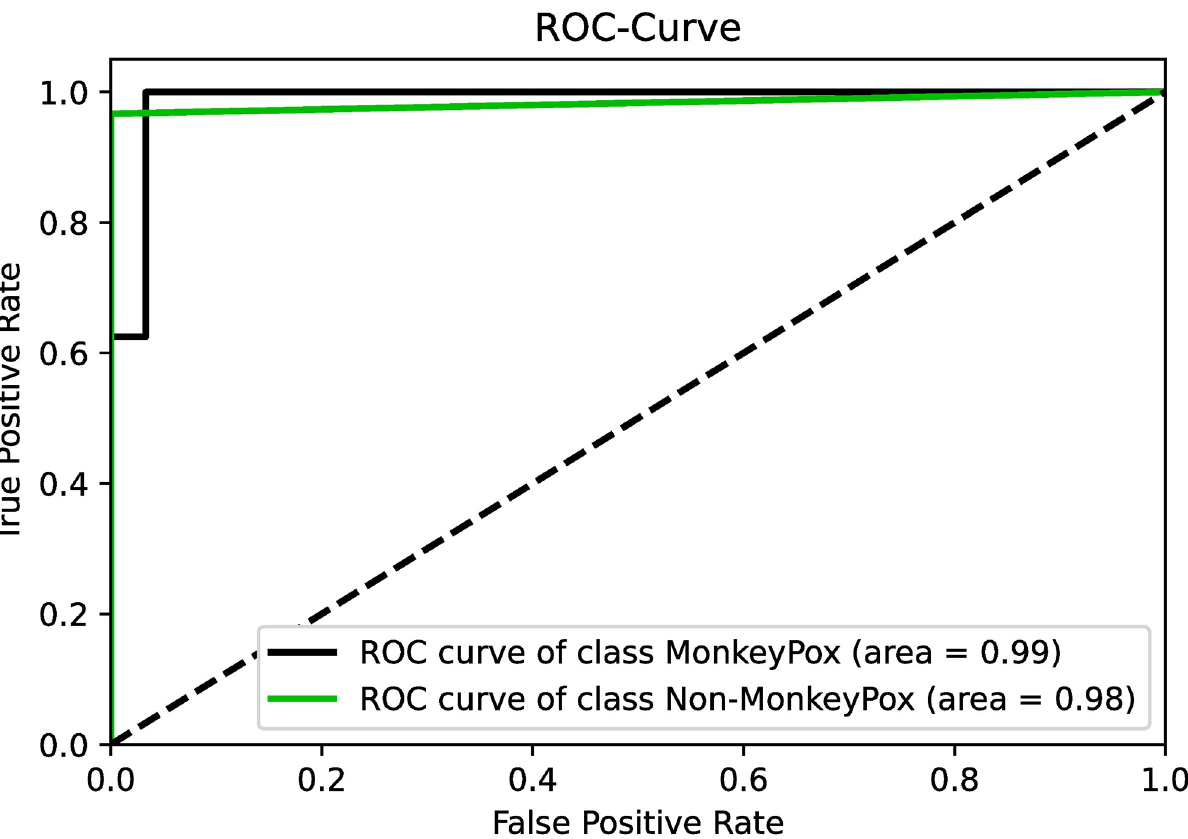
Fig 7. Post-ensemble ROC curves for both the Monkeypox and non-Monkeypox classes concerning Fold-1 of the experiment.